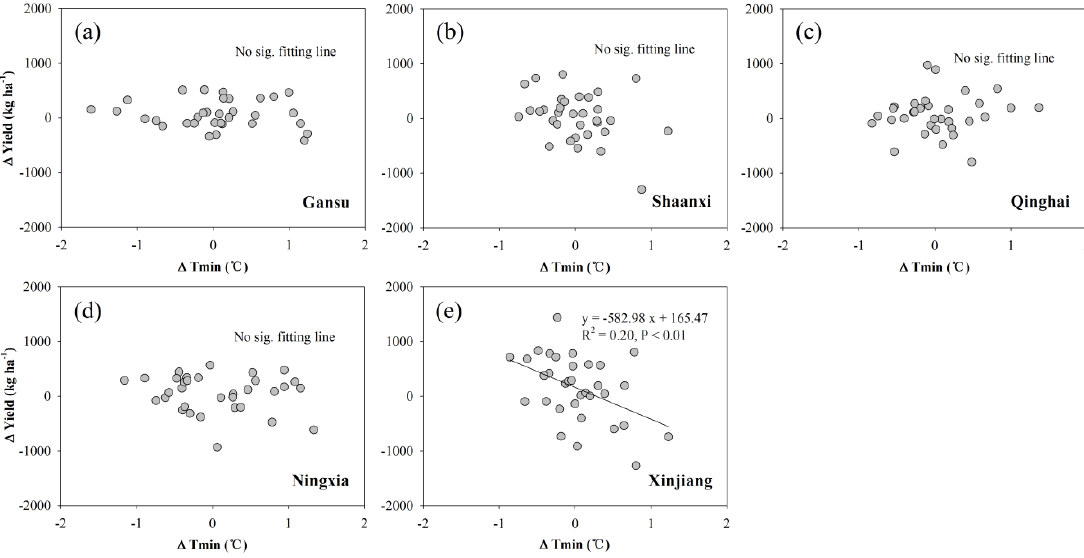
Figure 6. Relationships between changes in the daily minimum temperature and potato yield in different provinces of northwest China.